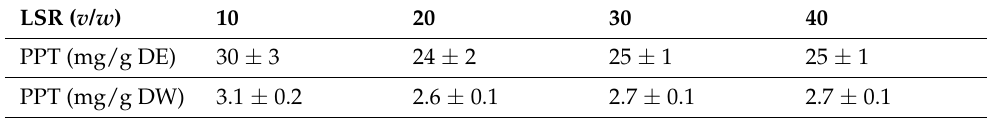
Table 3. Effect of the liquid-to-solid ratio on the PPT concentration relative to the obtained dry J. virginiana leaf extracts and to the weight of starting plant